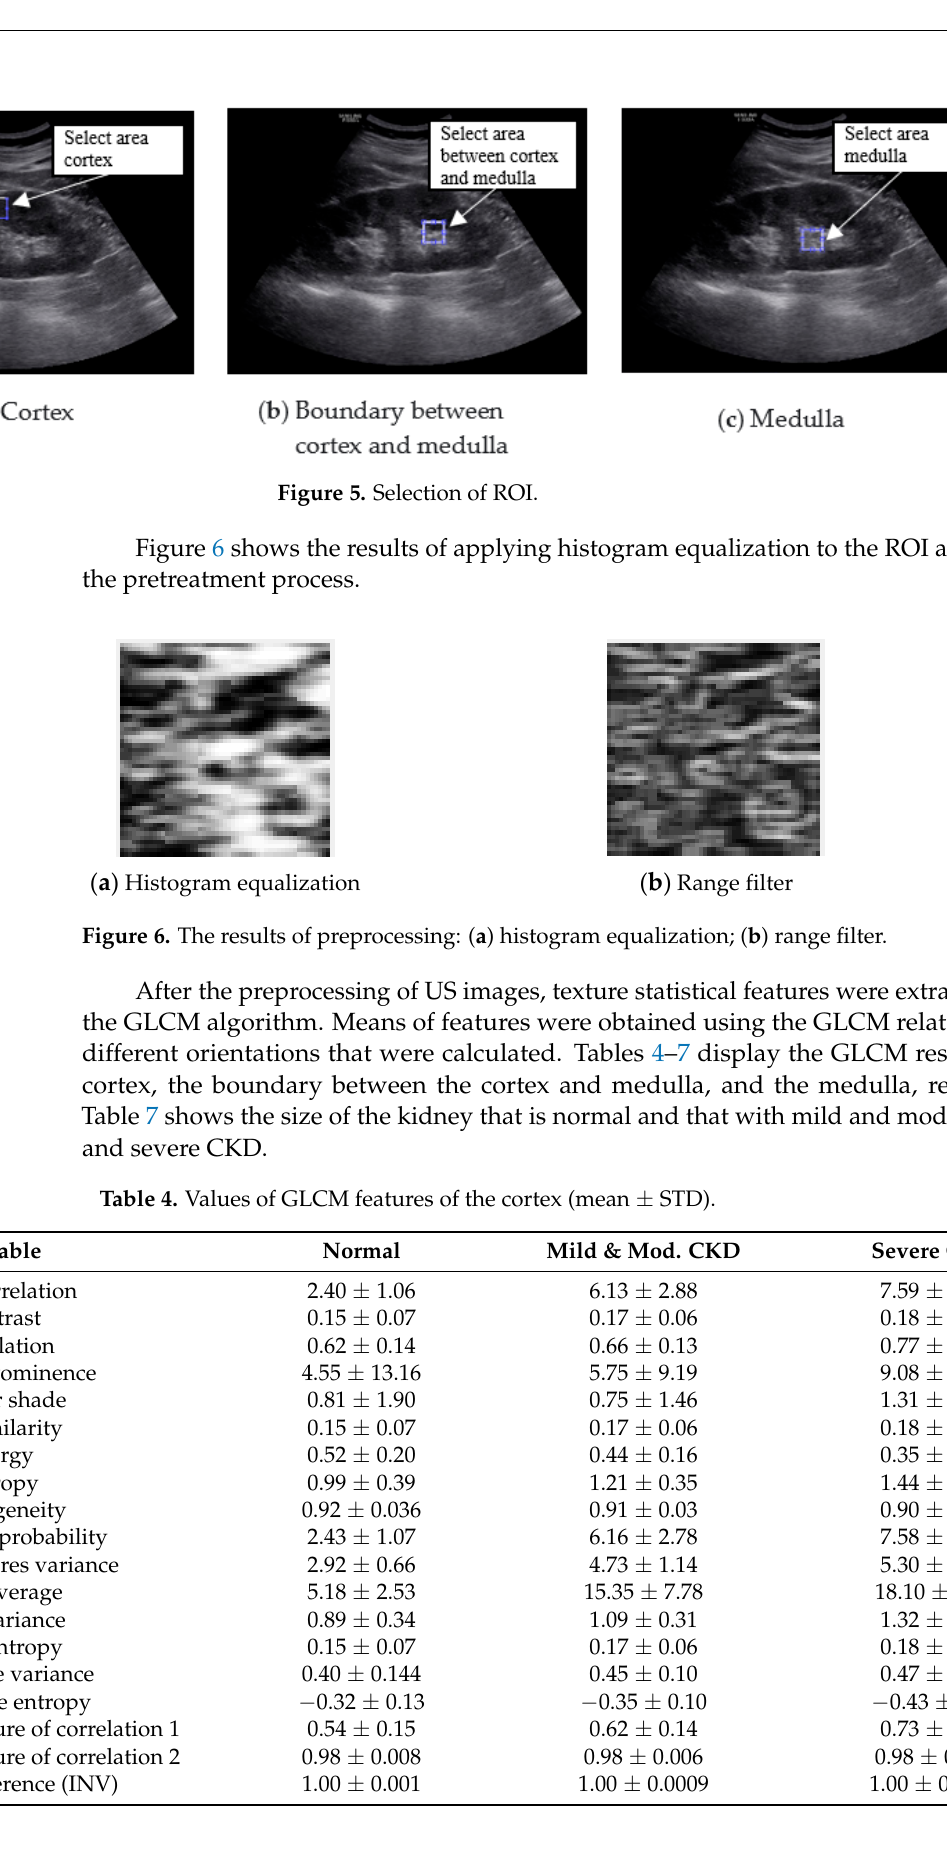
7 of 13 Figure 4. Output classification based on the ANN model. 3. Results